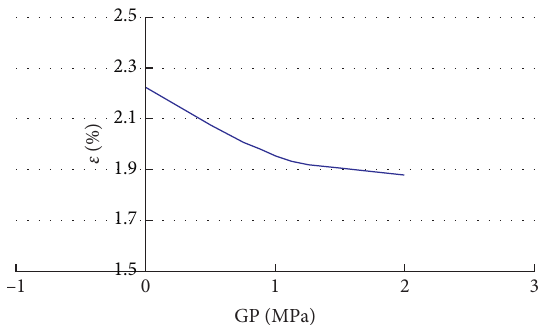
Figure 19: Variation in peak point plastic deformation for changing gas